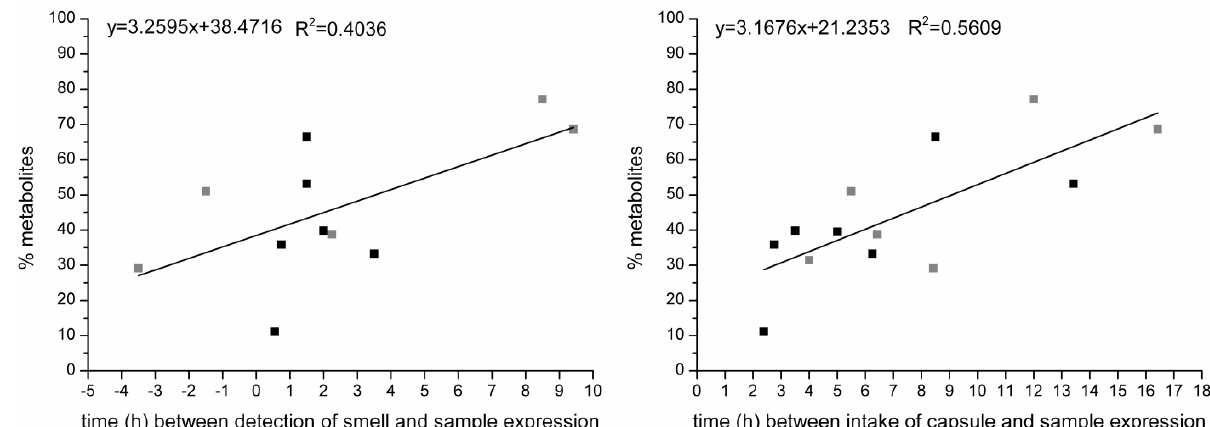
Figure 3. Time-dependency of metabolite